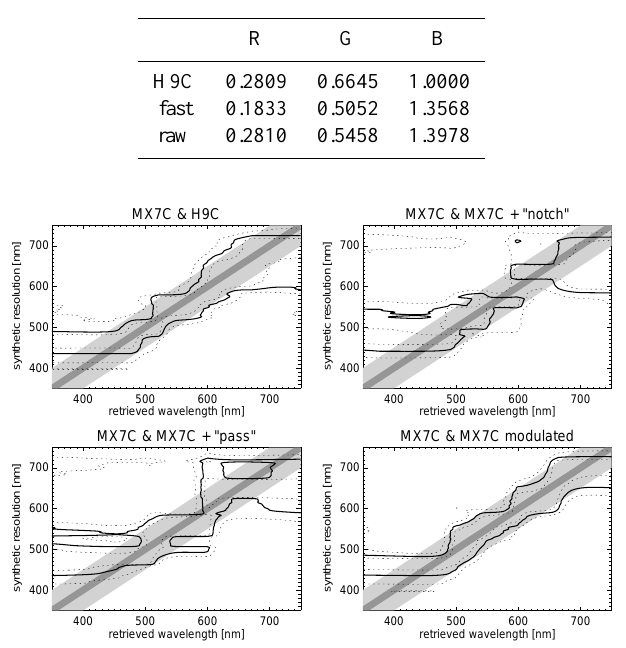
Table 4. Noise sensitivity as indicated by the rms (root mean square) value of coefficients in D matrix rows.